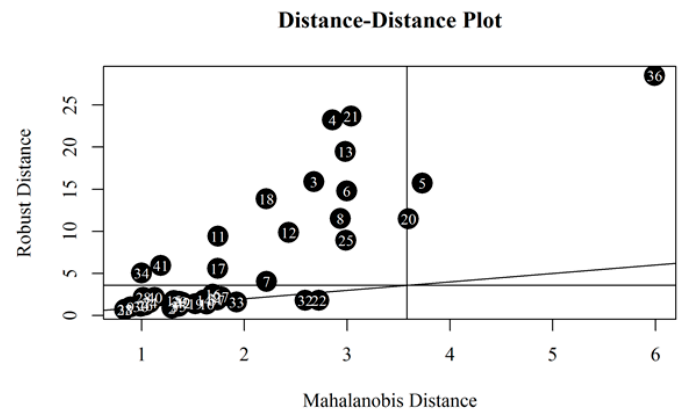
Figure 8. Mahalanobis distance-distance plot.